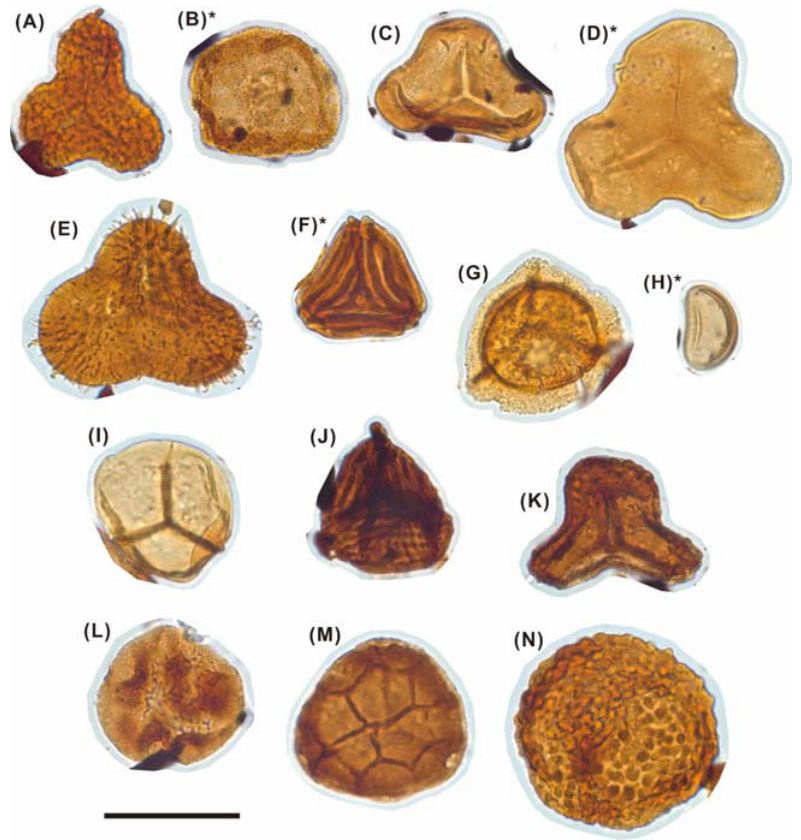
Figure 5. Photomicrographs of spores in oil shale and coal. ( A ) Concavissimisporites sp. ( B ) Os- mundacidites sp. ( C ) Cyathidites sp. ( D ) Cardioangulina sp. ( E ) Pilosisporites sp. ( F ) Cicatricosisporites purbeckensis. ( G ) Aequitriradites sp. ( H ) Laevigatosporites sp. ( I ) Biretisporites sp. ( J ) Appendicisporites sp. ( K ) Maculatisporites sp. ( L ) Brochotriletes degradatus. ( M ) Triporoletes sp. ( N ) Verrucosisporites sp. The scale bar represents 50 μ m. The photomicrographs marked with * are from [29].